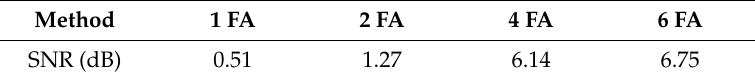
Table 3. SNR with the frequency accumulation